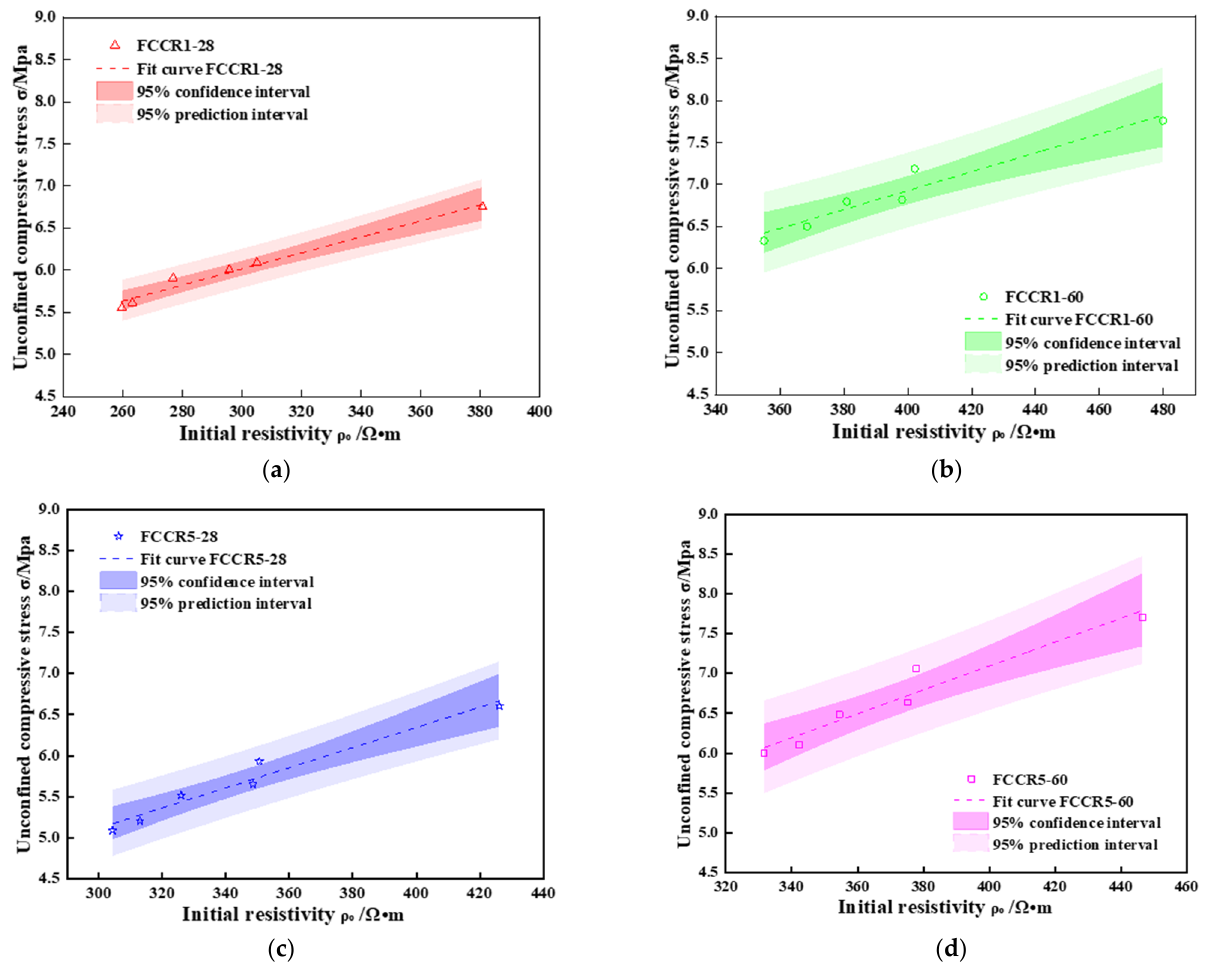
Figure 6. Relationship between UCS and IR. ( a ) UCS and IR fit curve of FCCR1-28; ( b ) UCS and IR fit curve of FCCR1-60; ( c ) UCS and IR fit curve of FCCR5-28; ( d ) UCS and IR fit curve of FCCR5-60. Table 4. Fitting relationship between UCS and IR.